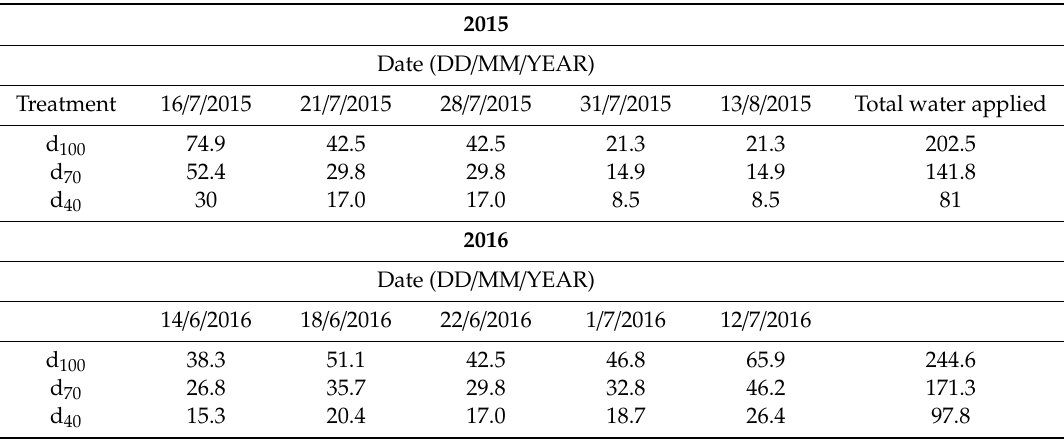
Table 2. Date and amount (mm) of applied irrigation water during the two years of the study and the three treatments (d 100 , d 70 , and d 40